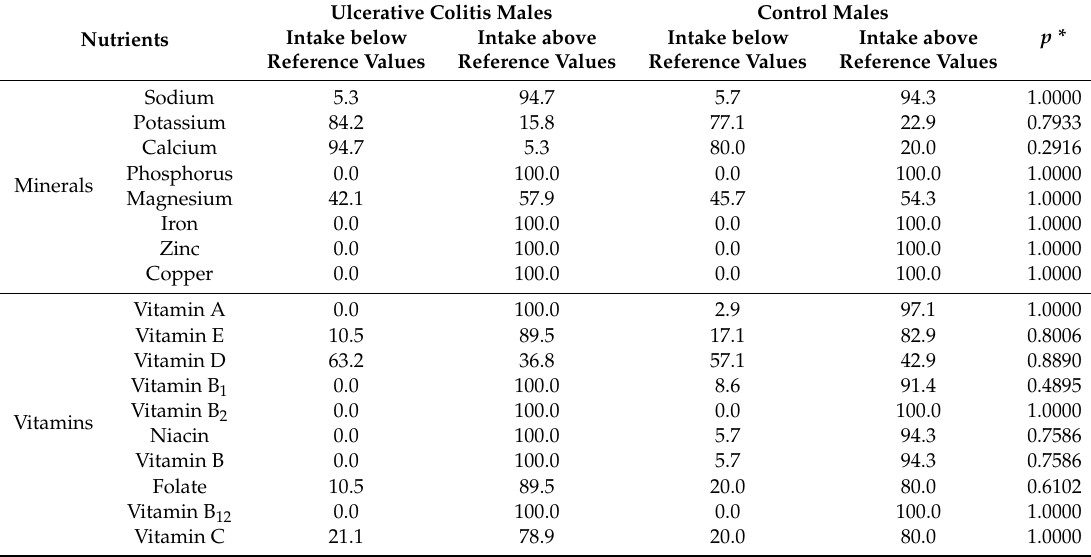
Table 10. The comparisons of the minerals and vitamins intake with the age-dependent reference intake estimated average requirement (EAR) / adequate intake (AI) values [33] in ulcerative colitis males and control